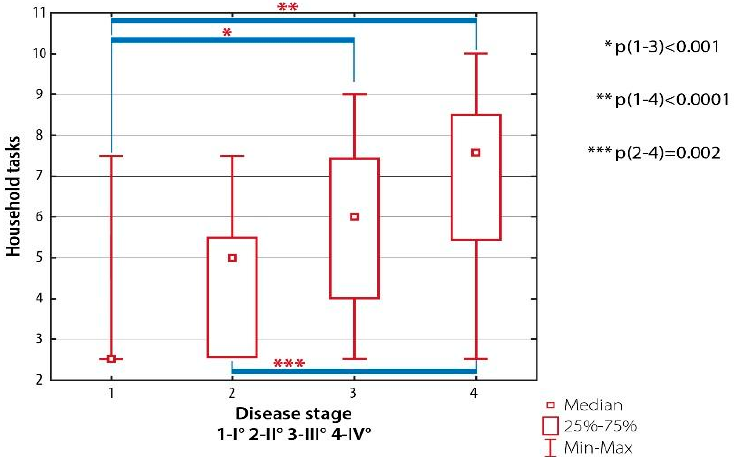
Figure 5. Inter-group differences in the quality of life evaluated with AIMS-2: household tasks, depending on the severity of radiological changes (the Steinbrocker classification).